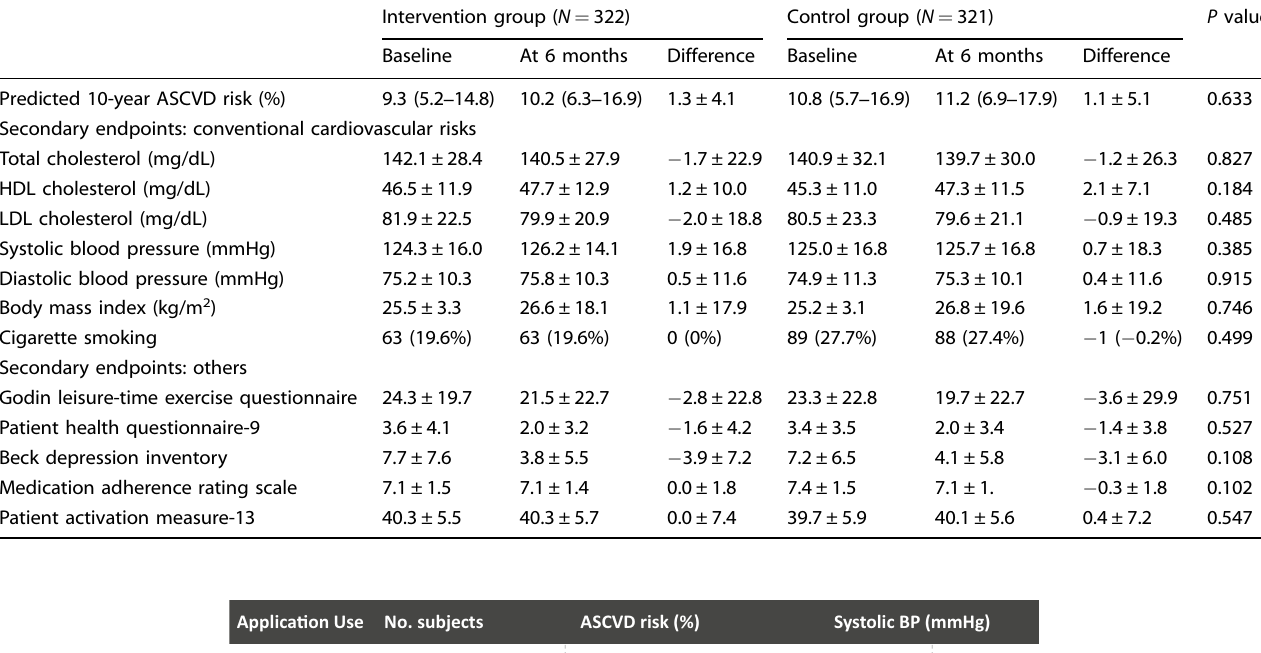
Table 2. Primary and secondary study endpoints at baseline and at 6 months after randomization.